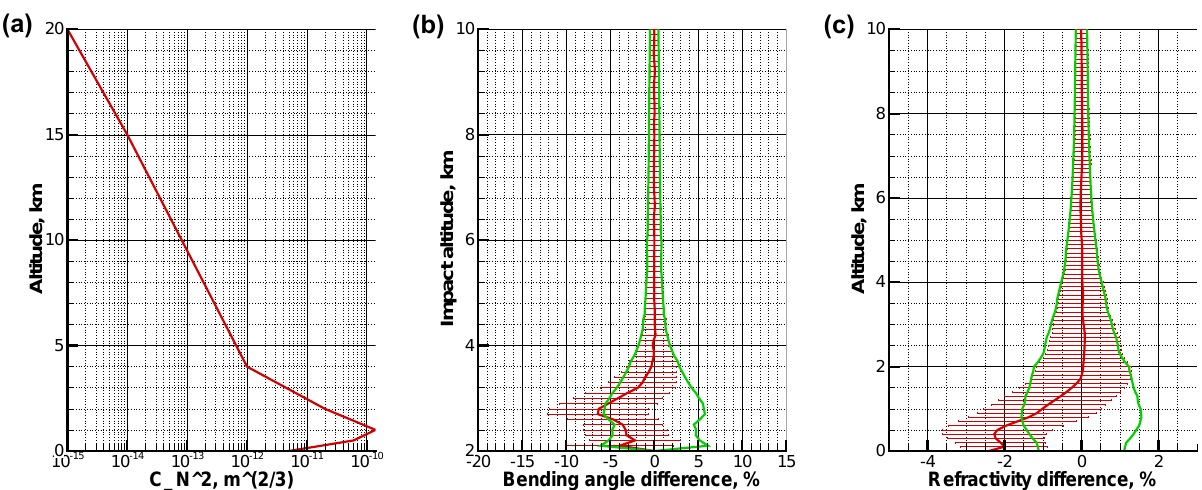
(z) profile (a) and associated N